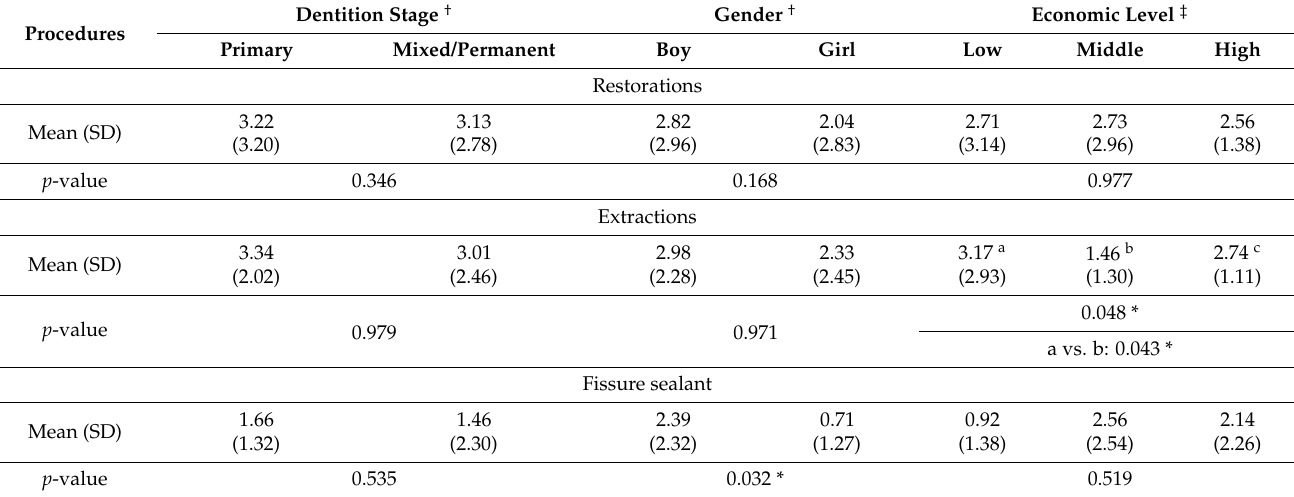
Table 4. The dental procedures provided to ASD children according to their demographic